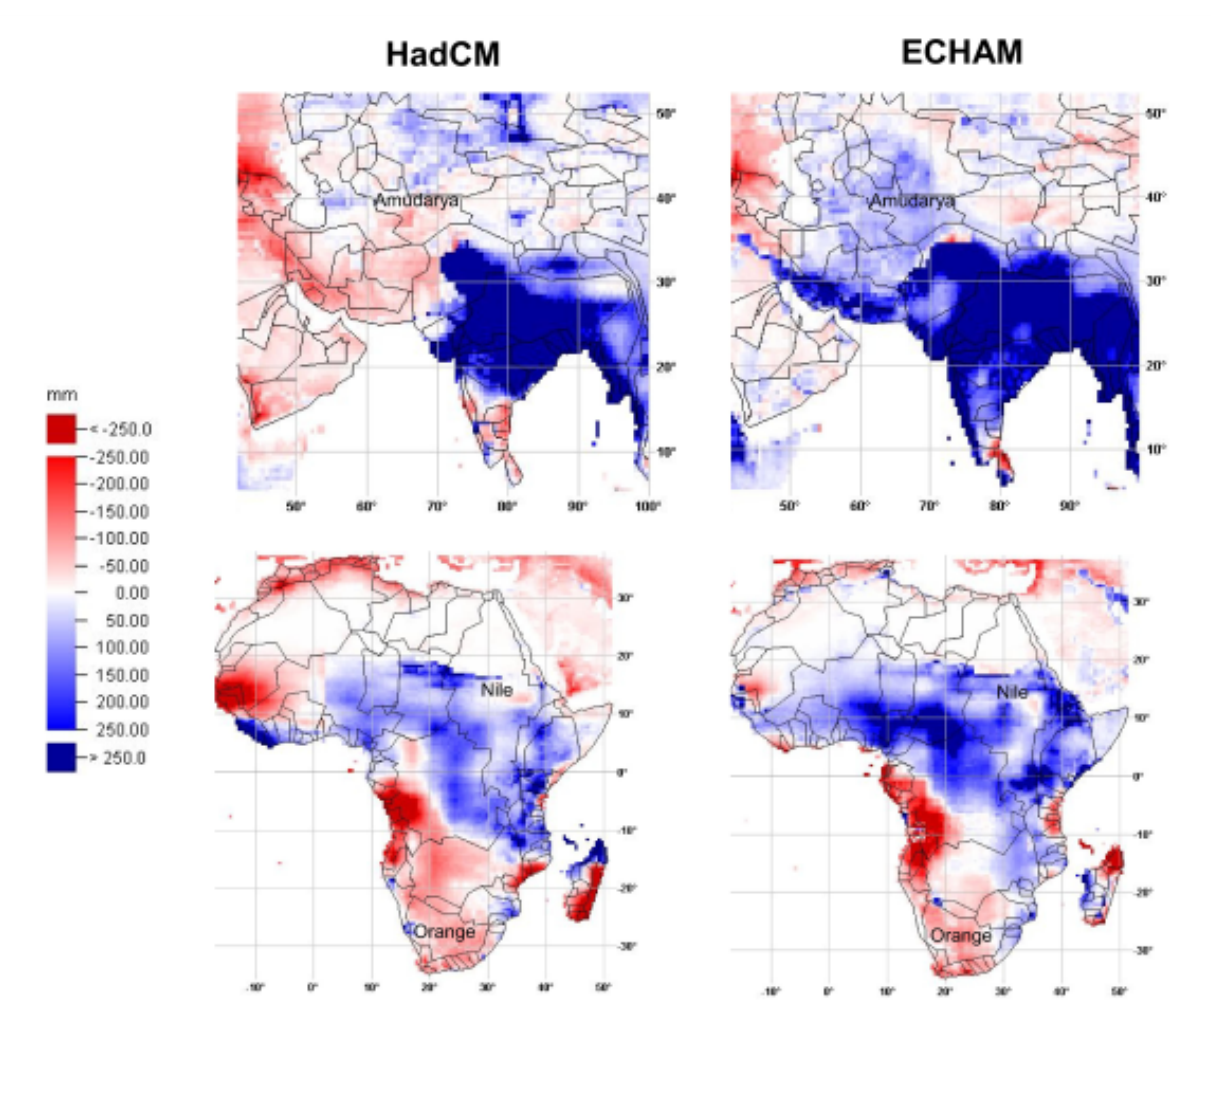
Fig. 2. Difference in average annual precipitation between scenario period 2041–2060 and reference period 1961–2000 as seen in climate models HadCM3 and ECHAM4 (resolution 0.5°) The basins are the Amudarya, Nile, and Orange, and the lines define catchment